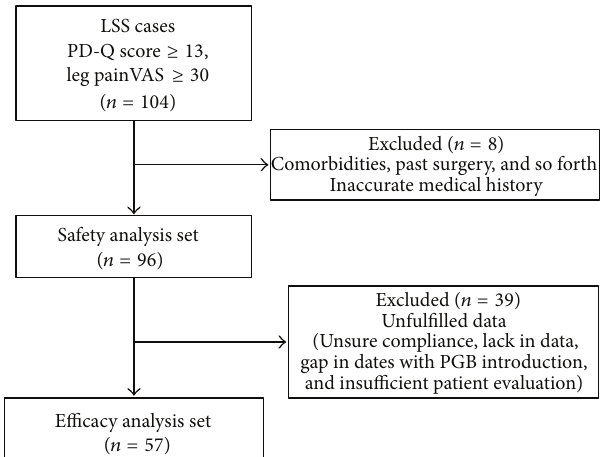
Figure 2: Patient selection flowchart. LSS: lumbar spinal stenosis; PD-Q: Pain DETECT questionnaire; VAS: visual analog scale; PGB: